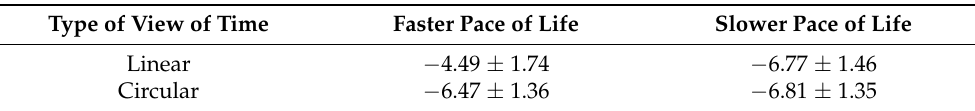
Table 2. Intertemporal decision scores (lnK) for participants with different paces of life under different views of time conditions ( M ± SD